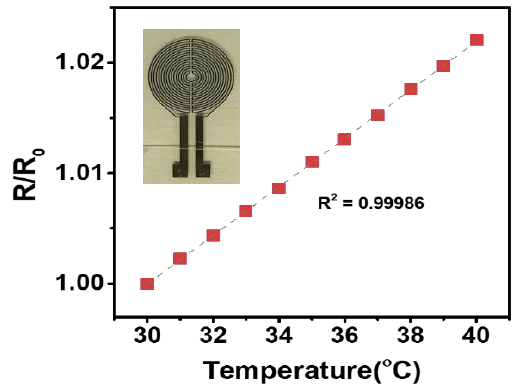
Figure 2. Sensor response (30–40 °C with an interval of 1 °C).